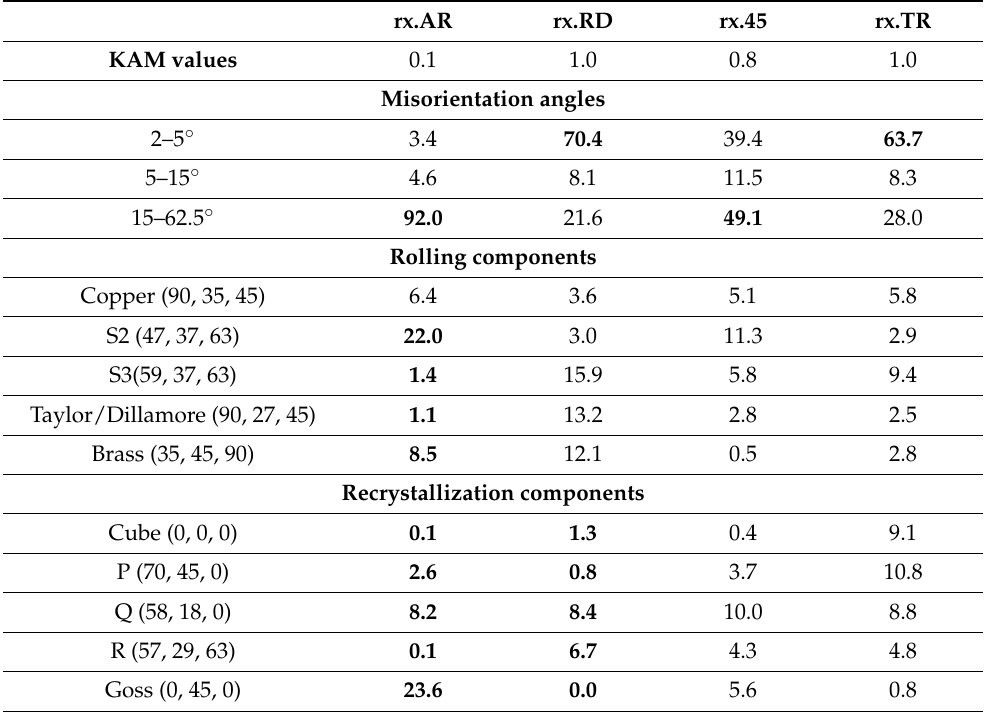
Table 6. KAM values, misorientation, and texture components of the recrystallized sheet